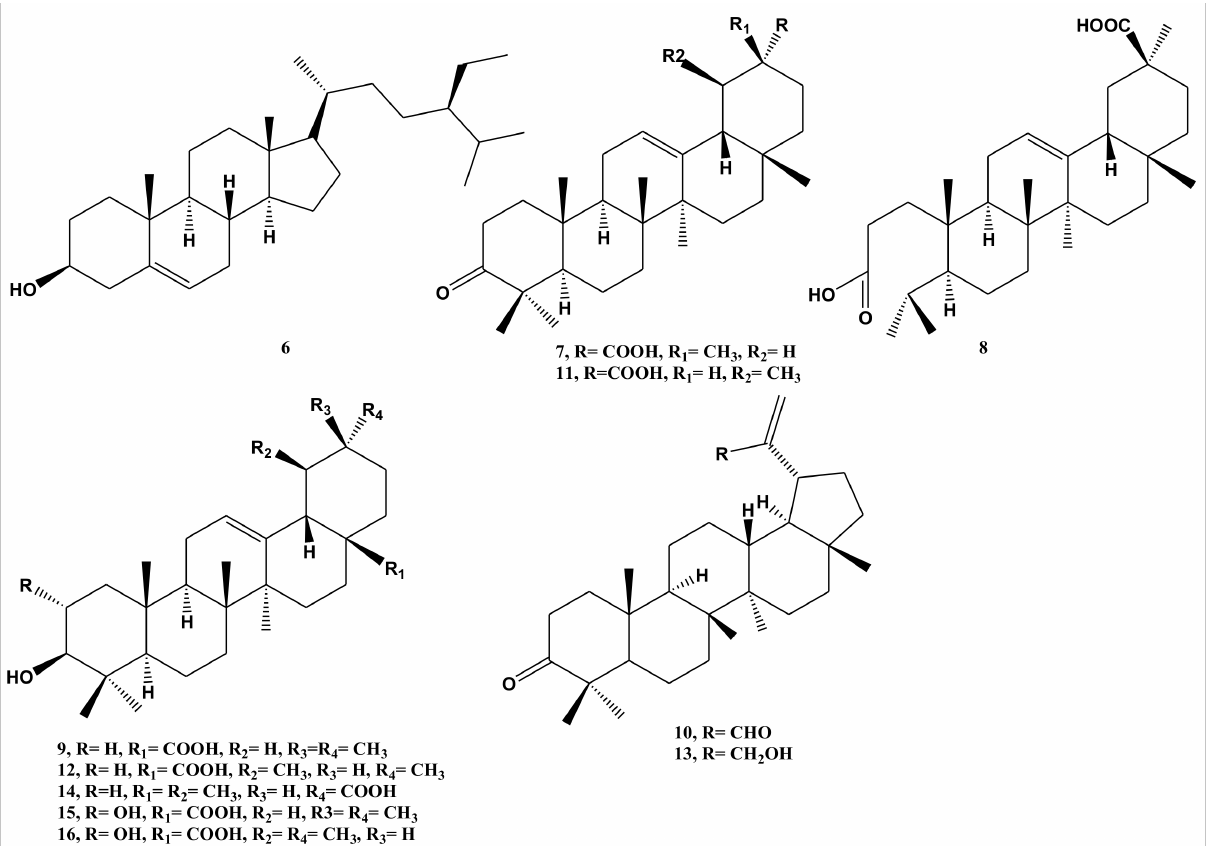
Figure 2. Chemical structures of the previously isolated compounds ( 6 – 16 ) from N. oppositifolia